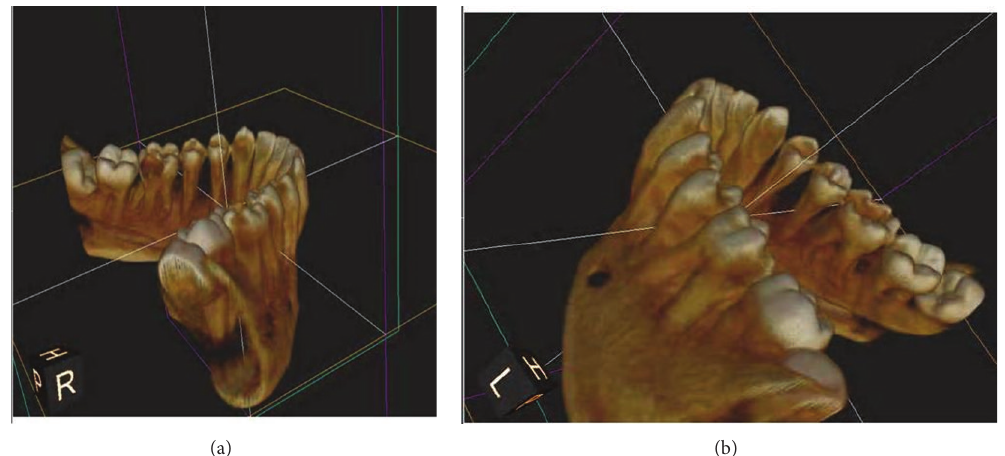
Figure 3: Oblique slicing showing root canal curvature of distolingual root of 36 and 46.